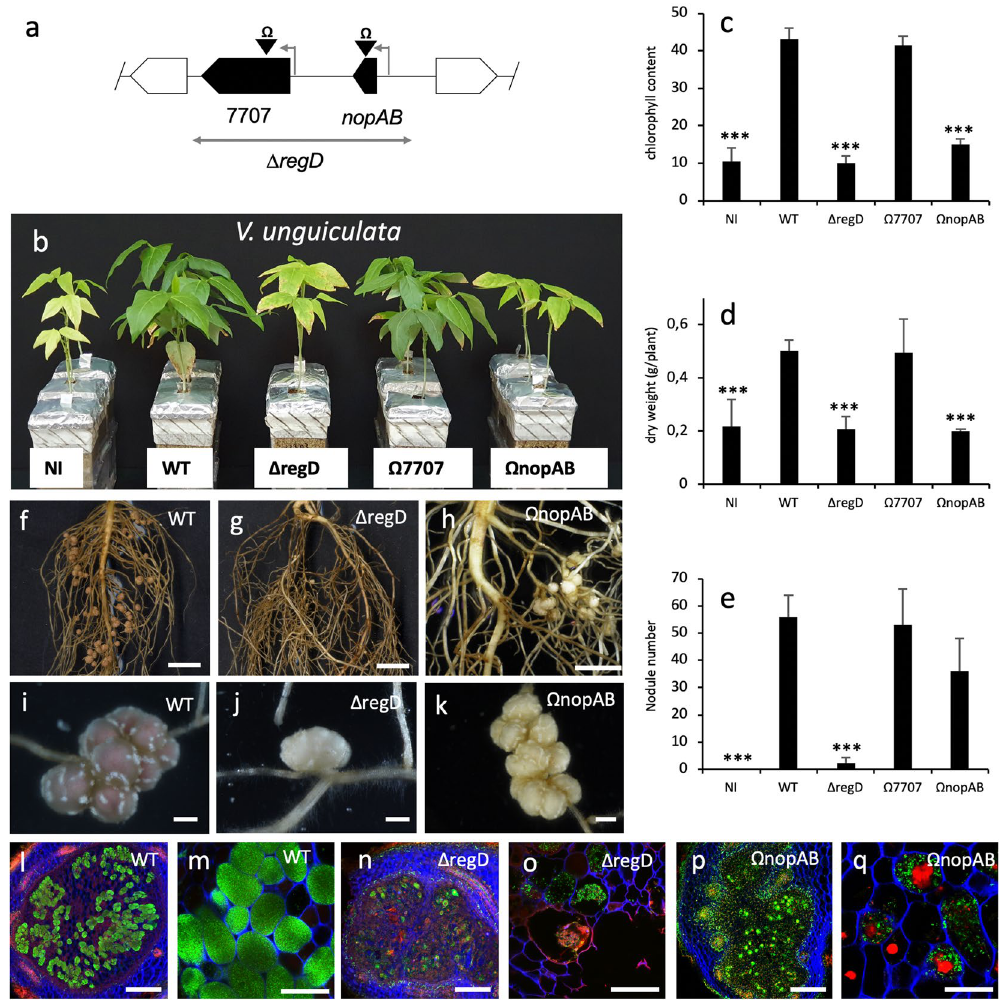
Figure 4. Symbiotic properties of the ORS3257 mutants in the different effectors of the region D in V. unguiculata . ( a ) Genetic organisation of the putative effectors and tts boxes identified in region D. The deleted region in the mutant is indicated by a double direction arrow. The insertion mutants are indicated by black arrowheads carrying the Ω sign. In black, putative effector genes; gray arrows, tts boxes. ( b ) Comparison of the growth of the plants (aerial part), non-inoculated (NI) or inoculated with ORS3257 wild-type strain (WT) or its derivative mutants at 21 days after inoculation. ( c ) Leaf chlorophyll content. ( d ) Plant dry weight; ( e ) Number of nodules per plant. The experiment was carried out in duplicate with five plants per condition. *P < 0.05, **P < 0.01, and ***P < 0.001, significant differences between WT ORS3257 and its derivative mutants using a nonparametric Kruskal–Wallis test. ( f – k ) View of the root and the nodules induced by strain ORS3257 and its derivative mutants. (Scale bars: f to h, 1 cm; i to k, 2 mm.) ( l – q ) Cytological analysis of the nodules induced by strain ORS3257 and its derivative mutants observed by confocal microscopy after staining with SYTO 9 (green: live bacteria), calcofluor (blue: plant cell wall), and propidium iodide (red: infected plant nuclei and dead bacteria or bacteria with compromised membranes). (Scale bars, l, n, p, 200 µm; m, o, q, 50